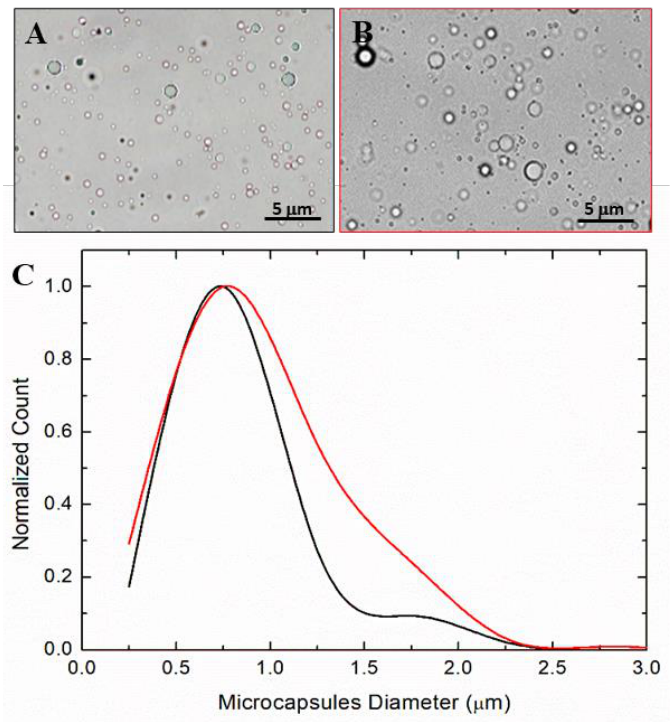
Figure 3. Optical microscopic images of glycogen from bovine liver microcapsules (BG mc ) prepared using 20 mg/mL BG + 50 μL SO: ( A ) (black box) day one and ( B ) (red box) mc after one month. ( C ) Comparison of normalized size distribution of BG mc day one (black) and one month later (red).